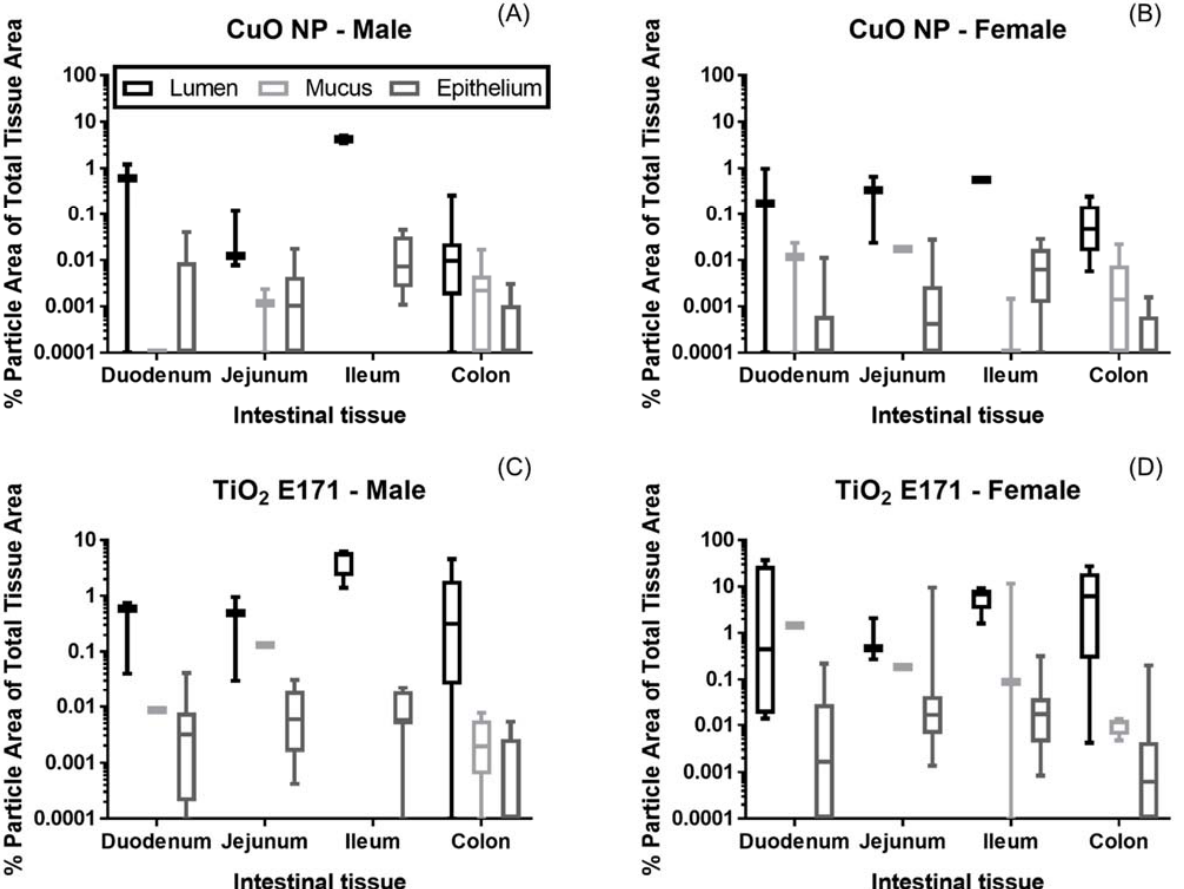
Figure 3. The percent (%) particle area of the total tissue area for CuO NPs ( A , B ) and TiO 2 E171 ( C , D ) found in Hyperspectral Imaging (HSI) images of intestinal cross sections of duodenum, jejunum, ileum, and colon for male ( A + C ) and female ( B + D ) rat pups dosed between PND 7–10 and sacrificed four hours after receiving the last dose. Box and whisker plots of the percent particle area of the total tissue areas are shown.